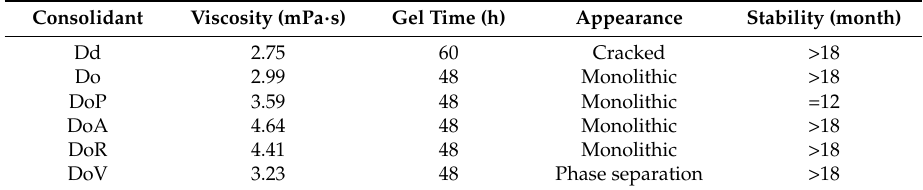
Table 2. Properties of sols and